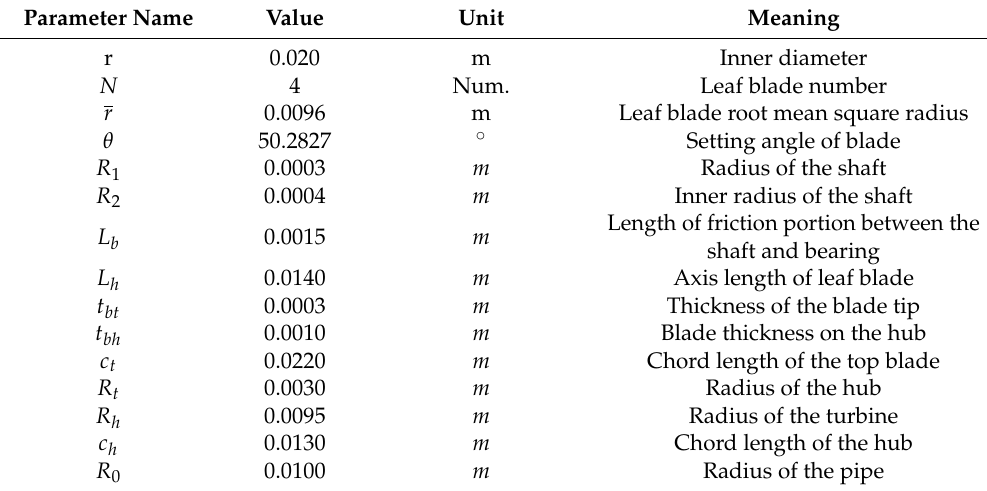
Figure 4. The turbine flow sensor model. Table 2 . Structure parameters of DN20 turbine flow sensor.